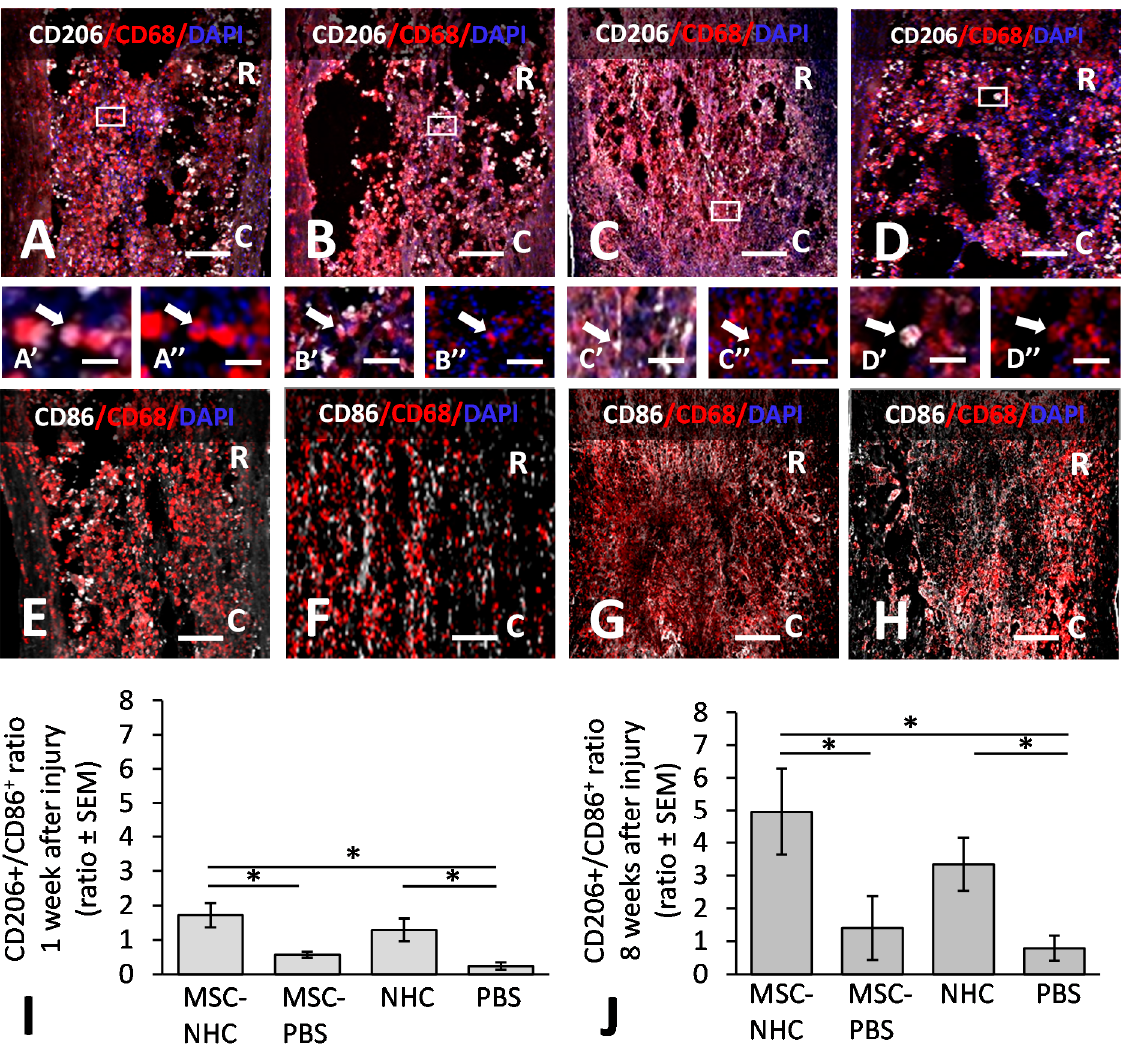
Figure 2. Inflammation polarization ratios in the injury site. Photomicrographs showing macrophages stained for CD206 (white), an anti-inflammatory macrophage marker, CD68 (red), a pan-macrophage marker, and the nucleus marker, DAPI (blue), in the injury site with MSC-NHC ( A ), MSC-PBS ( B ) NHC ( C ), or PBS ( D ) at 8 weeks after injury. Images in panels ( A’ – D’ ) (showing CD206, CD68, and DAPI) and ( A’’ – D’’ ) (showing CD68 and DAPI) are enlargements of the outlined area in panels ( A – D ), respectively. Scale bar in ( A , C ) is 250 µm, and 200 µm in ( B , D ). The scale bar in